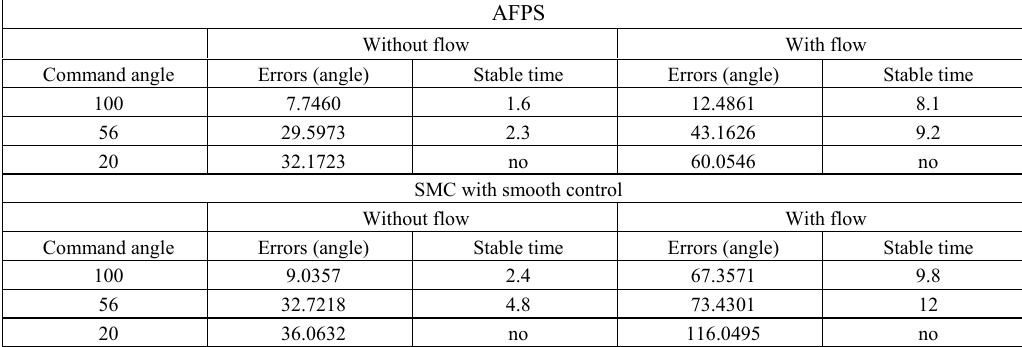
Table 1. Results